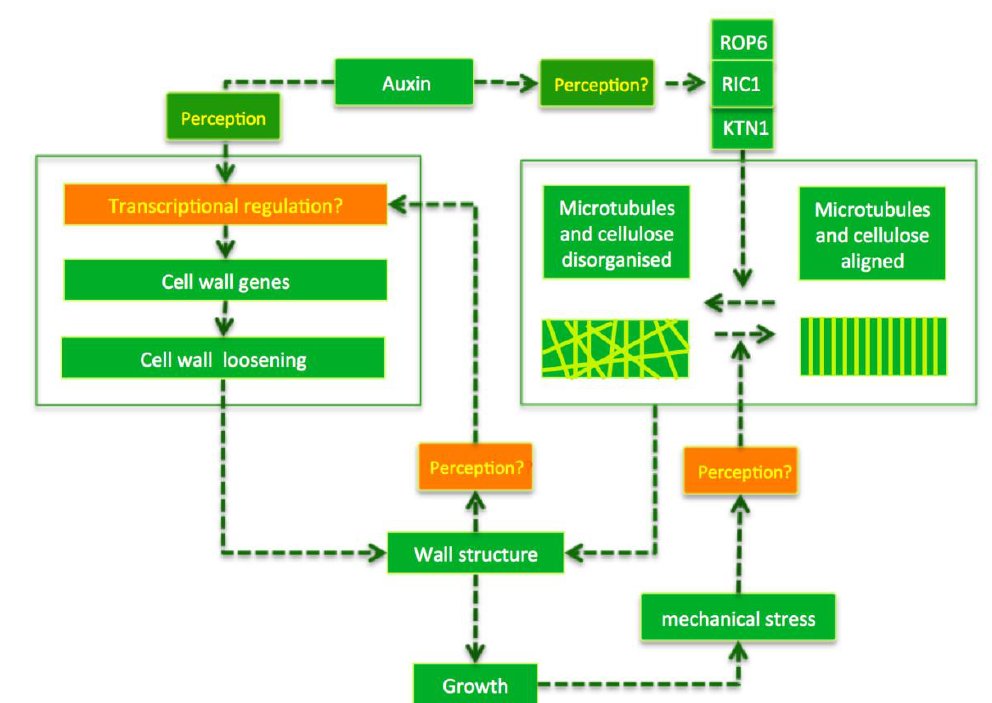
Figure 2. Some open questions. High auxin concentrations caused by auxin transport affects the cell wall structure in two manners during organ outgrowth: wall loosening (box at the left) and microtubule/microfibril organisation (pictured in the box on the right). Wall loosening involves transcriptional regulation. High auxin concentrations also promote a disorganisation of the microtubules, probably via a ROP/KTN based pathway (see also Figure 1), although this remains to be established. There is strong evidence that the cells perceive wall properties and mechanical stress and feed this information back to transcription and the cytoskeleton. Mechanical stress, for example, promotes microtubule alignment, while changes in wall anisotropy induce transcriptional responses. It is not known how wall structure and mechanical stress are perceived and transduced. Green arrows indicate positive regulation; orange boxes refer to the poorly understood processes that are discussed in the text.